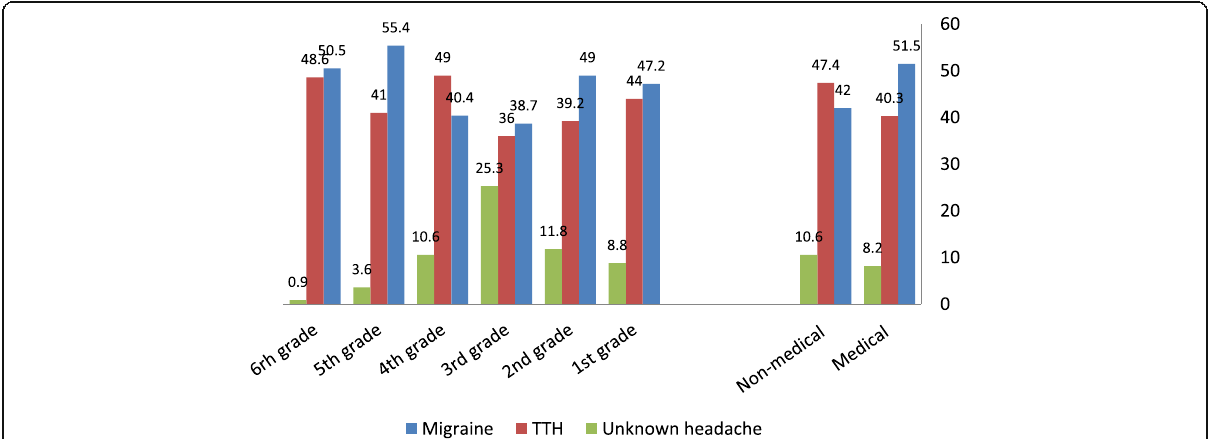
Fig. 1 Relationship between college students ’ grade and types of headache. N.B. For college type: ( χ 2 = 8.071 & p -value = 0.018). N.B. for students ’ grades ( χ 2 = 76.59 and p value < 0.001)